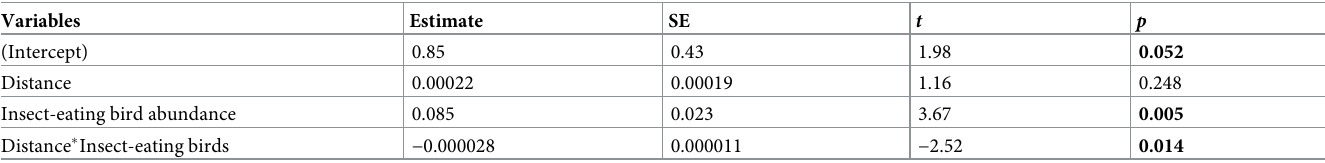
Note . Full model; Missing pest mimics = insect-eating birds + distance + insect-eating birds � distance, random = ~1|section, method = "ML". Significant p–values are given in bold. Pest mimic type was not significant when added to this model: Green mimics 0.024 ± 0.26, t = 0.09, P = 0.92; grey mimics -0.08 ± 0.25, t = -0.3, P = 0.76, brown mimics set to the